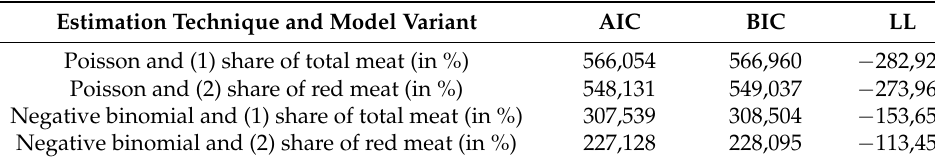
Table 3. Comparative fit indices Akaike information criterion (AIC), Bayesian information criterion (BIC), and log-likelihood (LL) for the two model variants. Estimation Technique and Model Variant AIC BIC LL 566,054 566,960 − 282,922 548,131 549,037 307,539 308,504 −